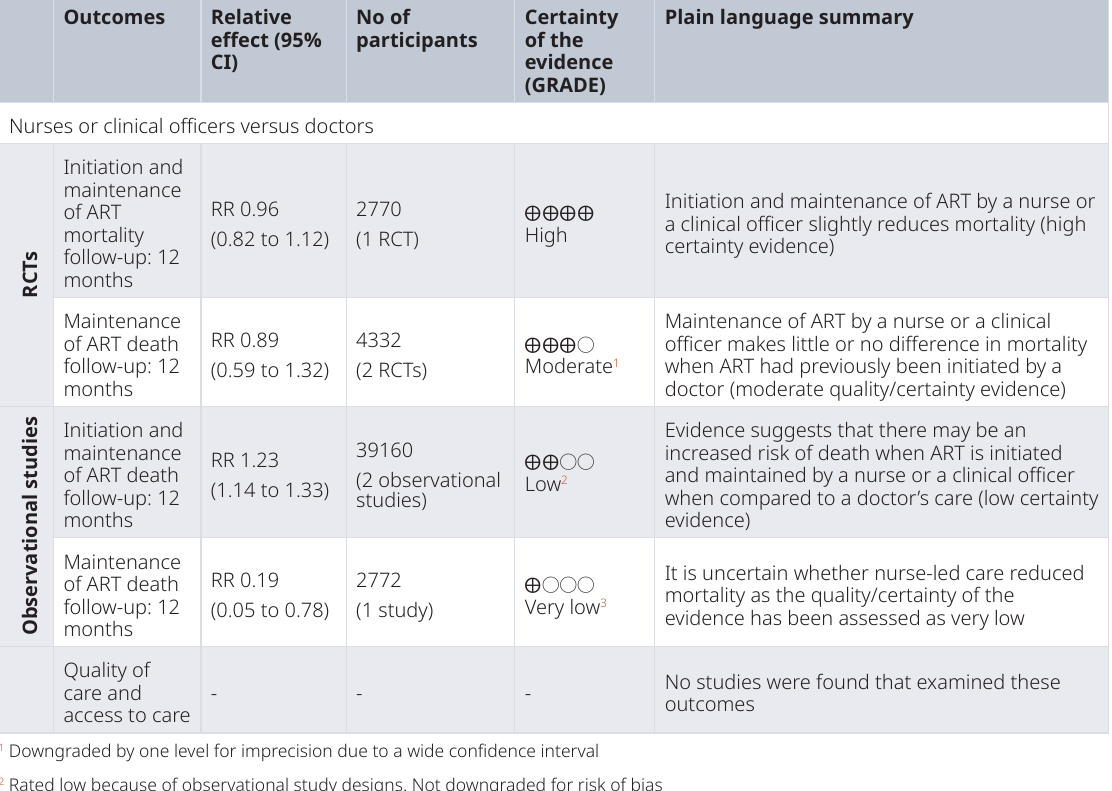
Table 4. Summary of findings for care provided by MLHPs for HIV/AIDS and ART.